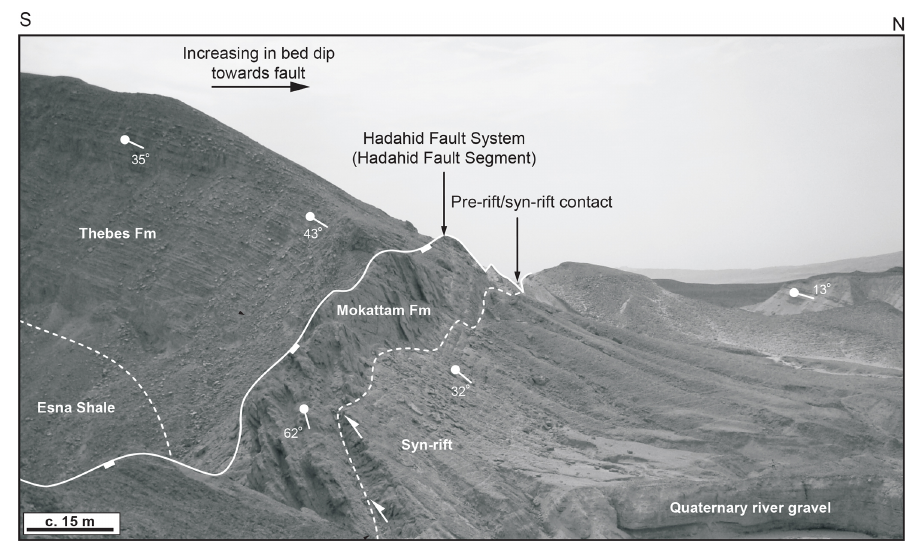
Figure 17. Photograph looking westwards along the Hadahid Fault Segment. Note the angular discordance of ca. 10 ◦ between the pre-rift (Mokattam Formation) and overlying syn-rift strata (Nukhul Formation) (see Lewis et al., 2015). Location of the photo is shown in Fig.